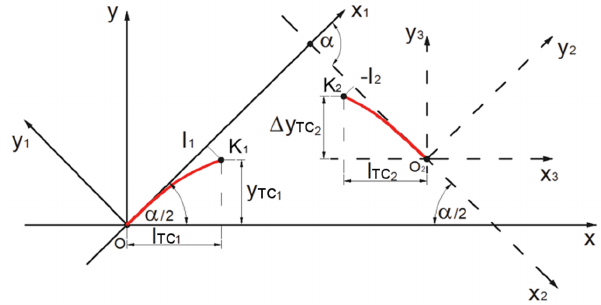
Figure 2: Assumed local coordinates system (with inscribed transi- tion